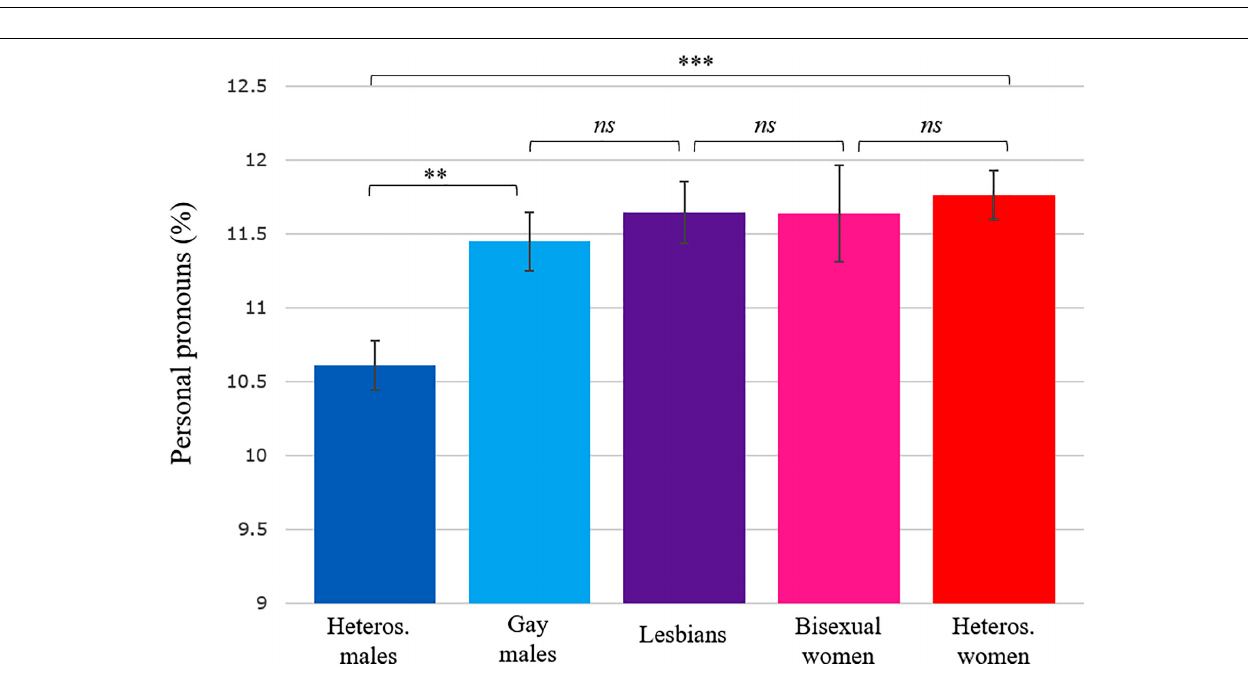
FIGURE 5 | Estimated marginal means and standard errors for personal pronoun frequency in each group of authors. The estimated marginal means are adjusted for differences in publication year and author’s age at publication. ∗∗∗ p < 0.001, ∗∗ p < 0.01. ns , non-significant.